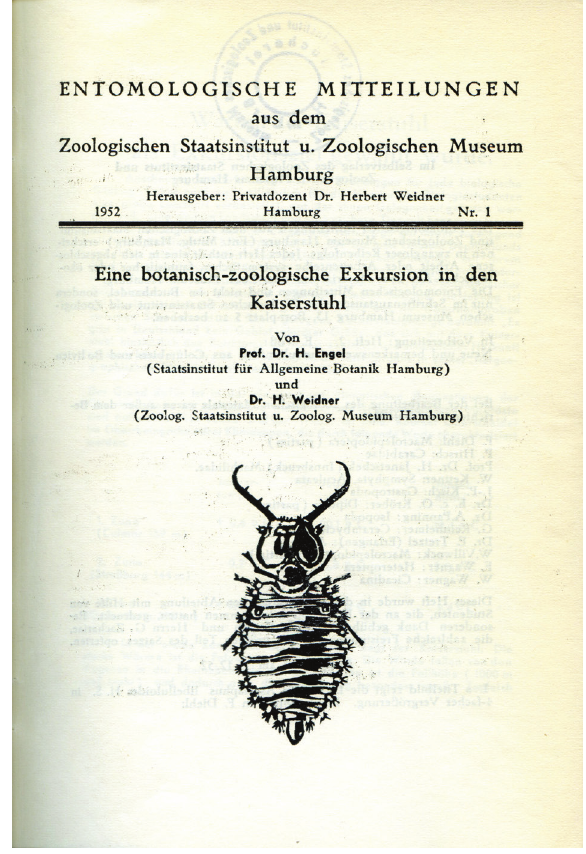
Figure 3. Title page of the “ Entomologische Mitteilungen aus dem Zoologischen Museum Hamburg ”, founded in 1952 by Herbert